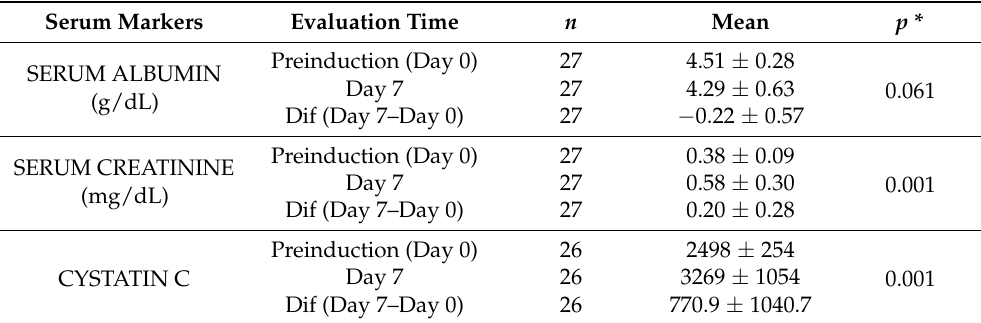
Table 1. Serum albumin, creatinine and cystatin C evaluation. Evaluation of serum markers prein- duction (Day 0) and at 7 days after CKD induction with adenine. A significant increase was observed in creatinine and cystatin C but not albumin. The data in the figures are reported as the mean ± sd. * p < 0.05 is considered significant.